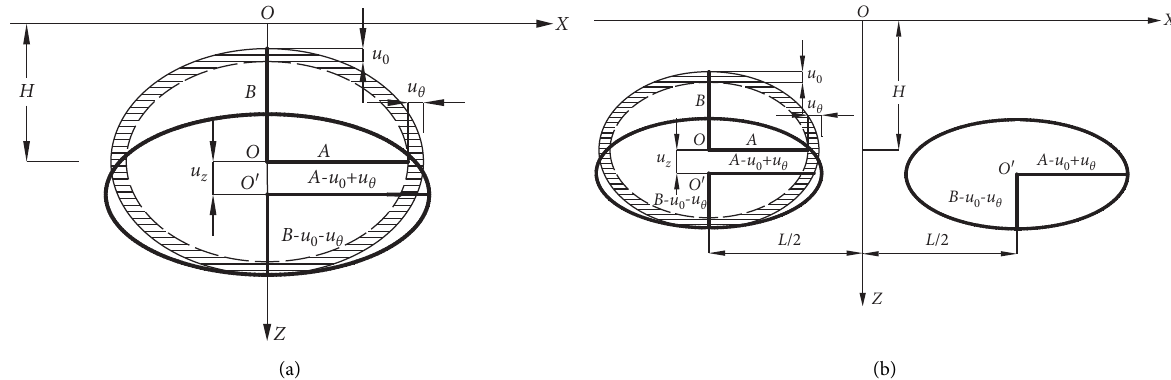
Figure 2: Sketch of asymmetrical convergence deformation mode ( u deformation, and u z denotes the rigid vertical settlement).